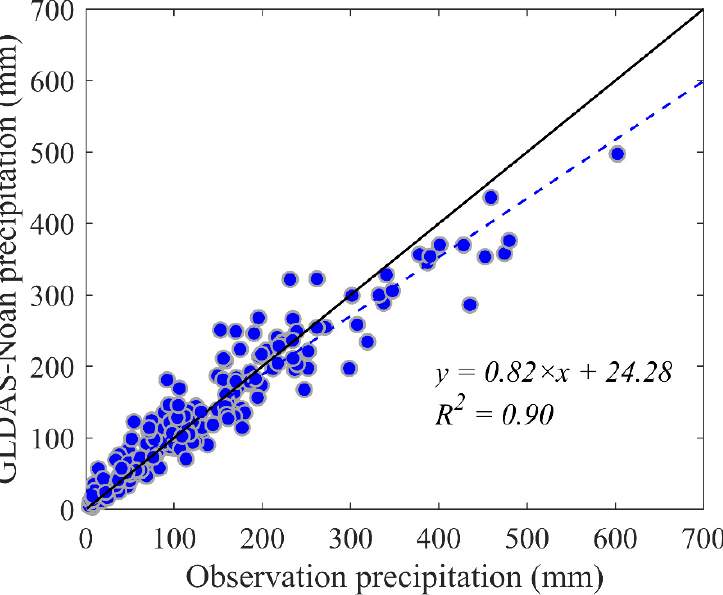
Figure 2. Scatter plot of monthly precipitation from station observations and the GLDAS-Noah in the MRB.